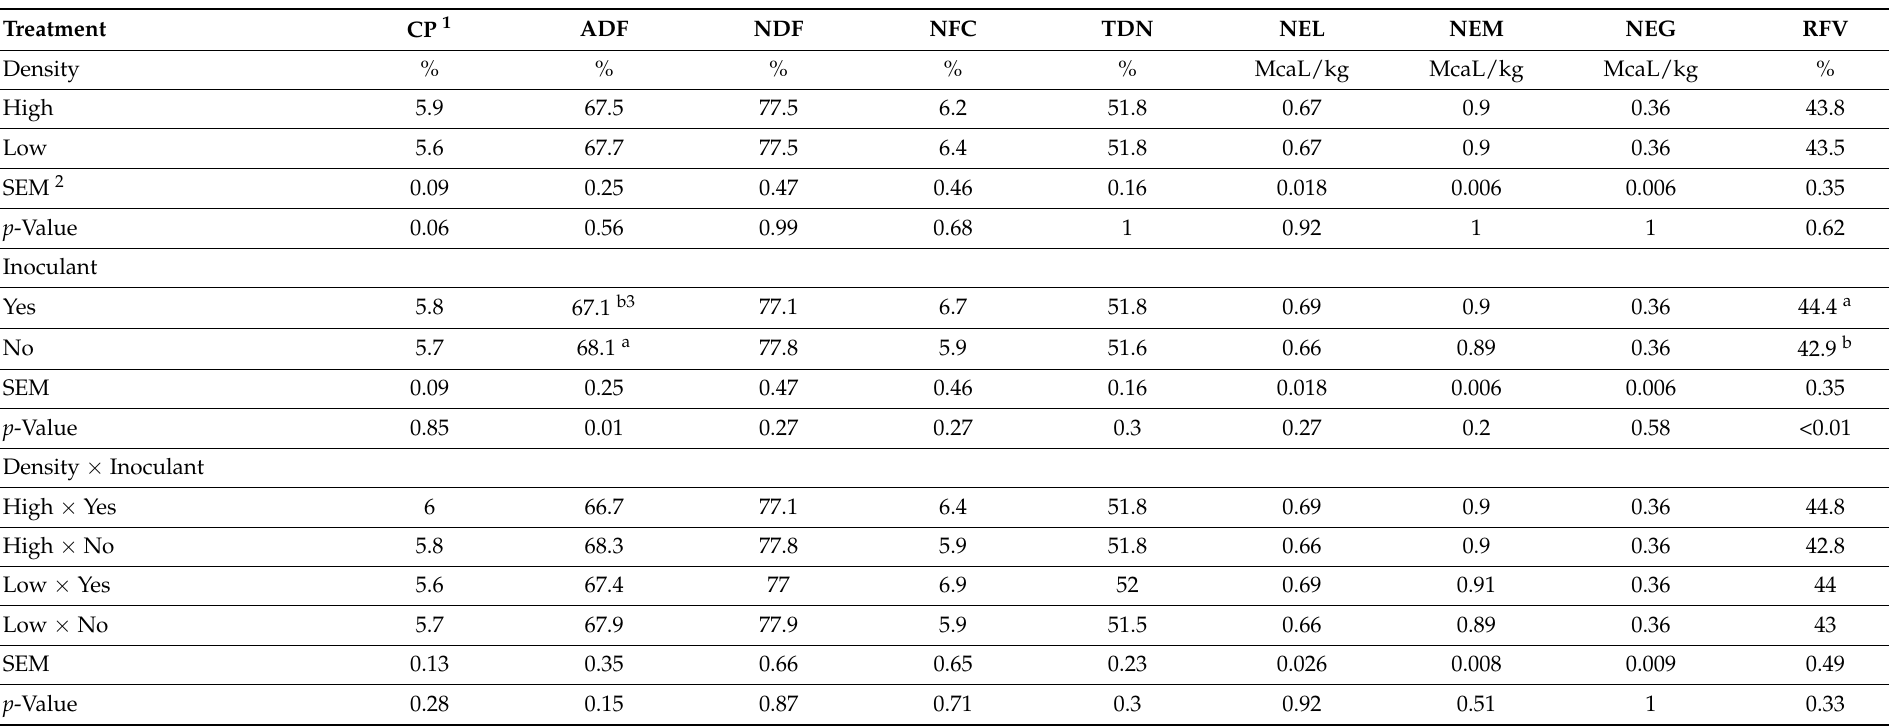
Table 2. Nutritional values for elderberry silage by main effect and interaction of density (High and Low) and inoculation (Yes or No)